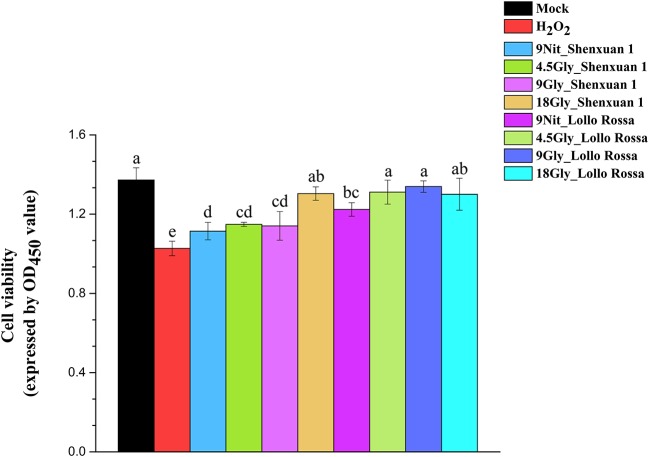
Effect of glycine or nitrate supply on the H2O2 scavenging ability of lettuce leaf extracts in the CCK-8 assay. Different small letters indicate significant differences, p < 0.05; LSD analysis (n = 3).